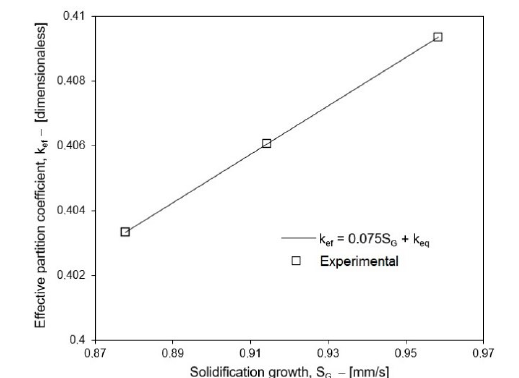
) versus solidification ef